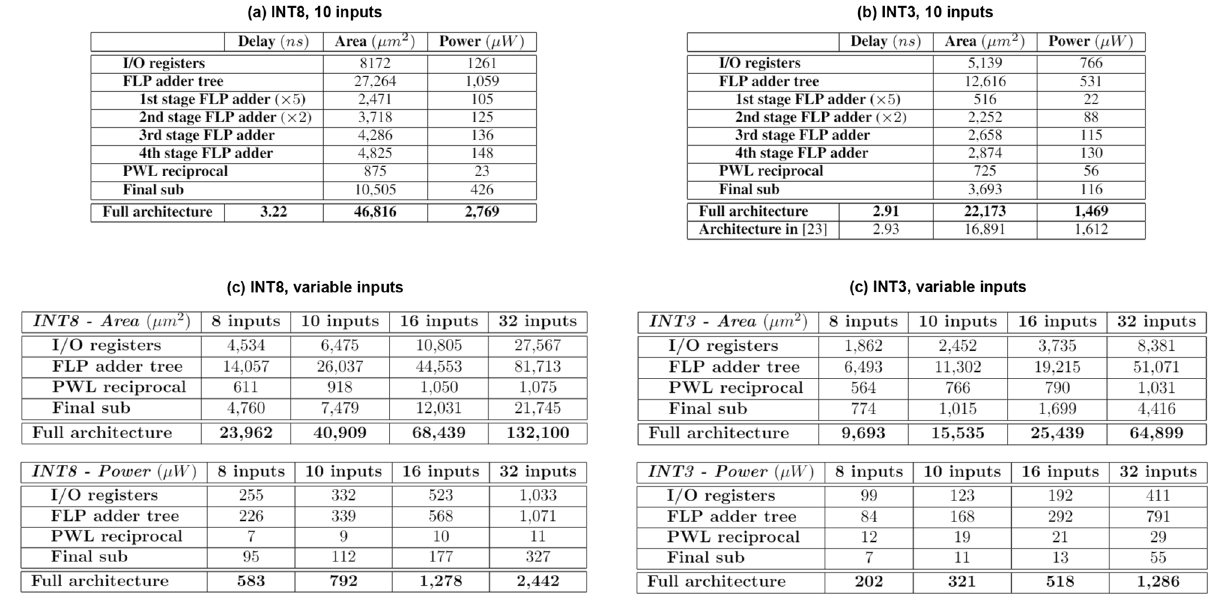
Figure 8. ( a ) Pseudo-softmax implementation results for a INT8, N = 10 classes architecture. ( b ) Pseudo- softmax implementation results for a 3 bit quantized, N = 10 classes architecture, and comparison with 23 . ( c ) Pseudo-softmax INT8 architectures implementation results for different number of inputs. ( d ) Pseudo-softmax INT3 architectures implementation results for different number of